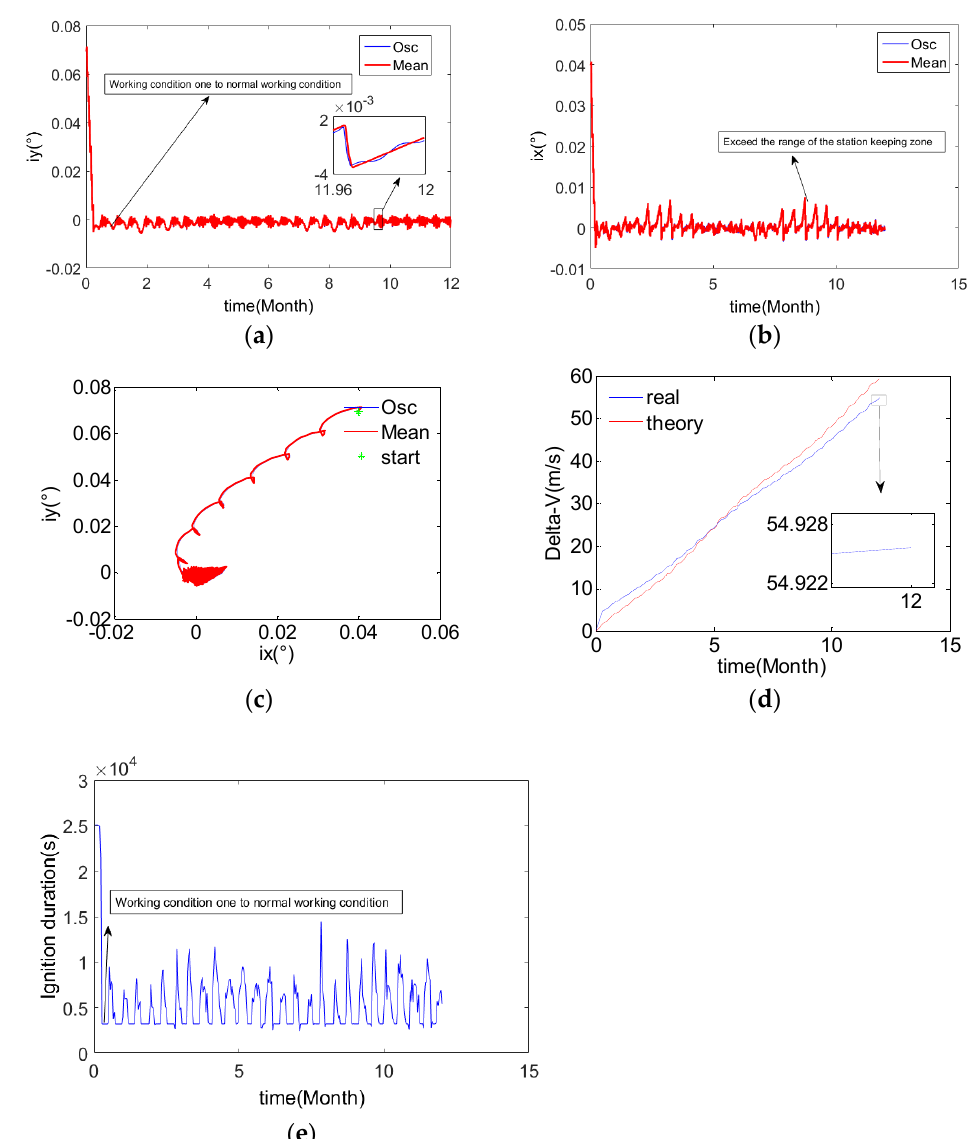
Figure 18. The results of the example five. ( a ) Y-axis component of orbital inclination vector; ( b ) X-axis component of orbital inclination vector; ( c ) Orbital inclination vector; ( d ) Velocity increment for SK; ( e ) Duration of SK.